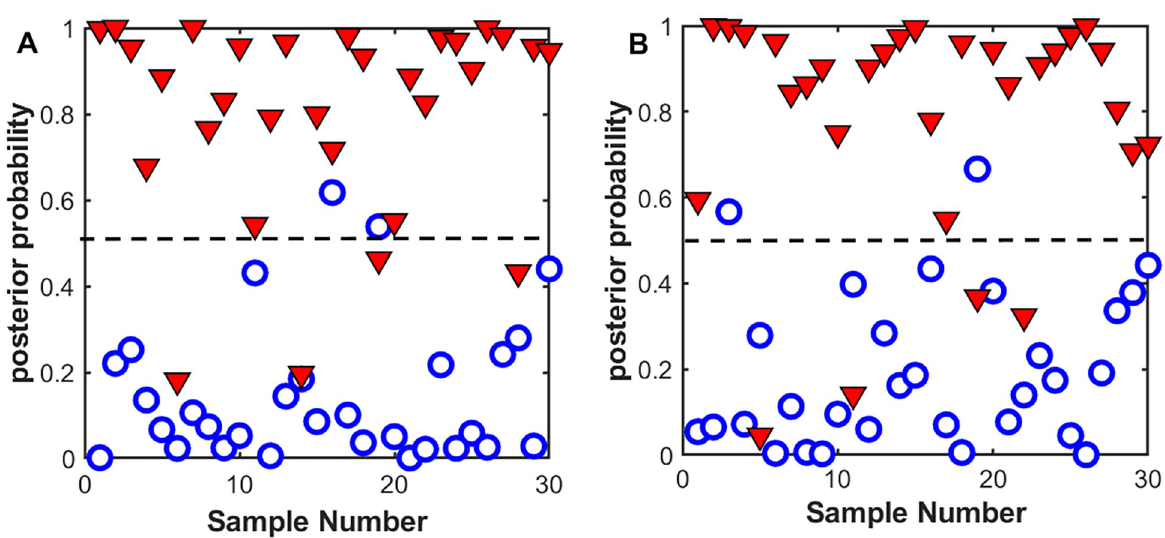
Fig 5. Scatter plots of the posterior probability of belonging to cholangiocarcinoma (n = 30) and healthy groups (n = 30). The posterior probability results were acquired by (A) the peak height analysis of the marker bands combined with LDA and (B) the PCA-LDA algorithm utilizing the first 10 PCs. The dotted line represented the discrimination threshold of 0.5.